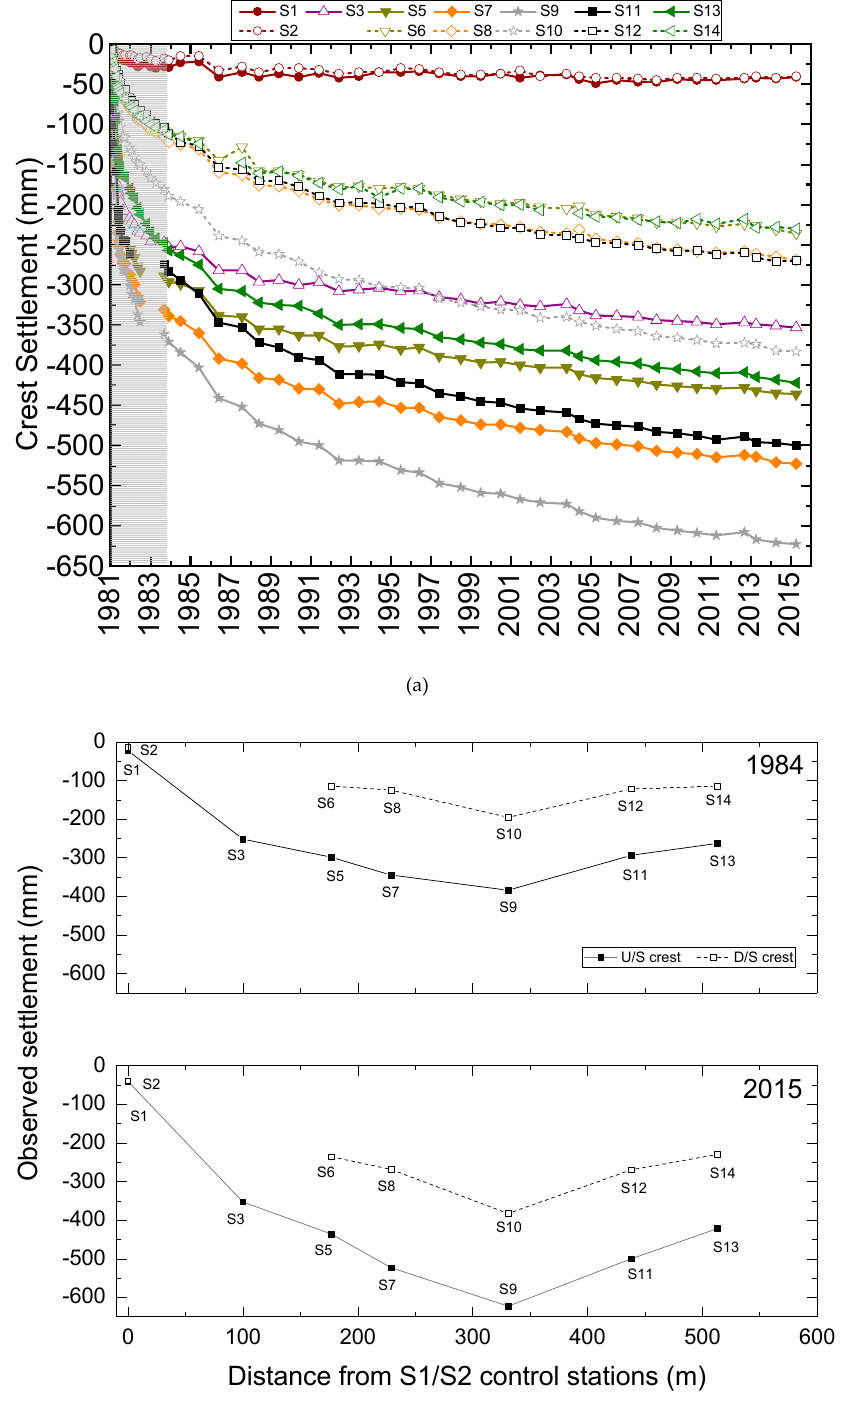
Figure 4. ( a ) Time evolution of the crest settlements of the Pournari I dam. The shadowed area corresponds to the first three filling cycles, and is not taken into account in this study. ( b ) Observed settlement for the control stations along the upstream (U / S) (solid line) and the downstream (D / S) (dashed line) side of the crest on 1 July 1984 (top) and on 1 April 2015